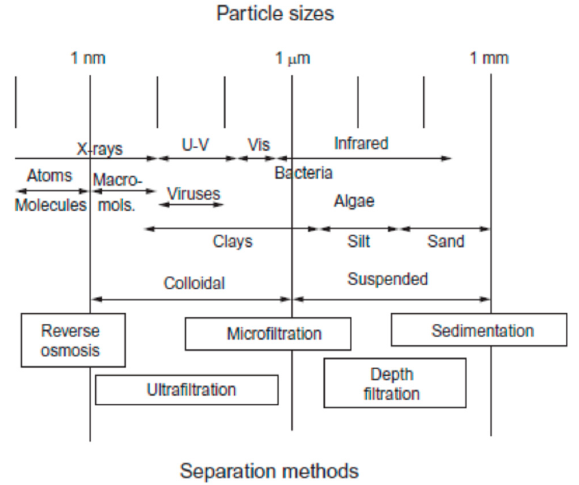
Figure 7. Schematic diagram of the filtration spectrum of related separation processes and separated components [37]. Reproduced with permission from Ikhsan, S.N.W.; Yusof, N.; Ismail, A.F.; Salleh, W.N.W.; Aziz, F.; Jaafar, J.; Hasbullah, H, Synthetic Polymeric Membranes for Advanced Water Treatment, Gas Separation, and Energy Sustainability; published by Elsevier, 2020.